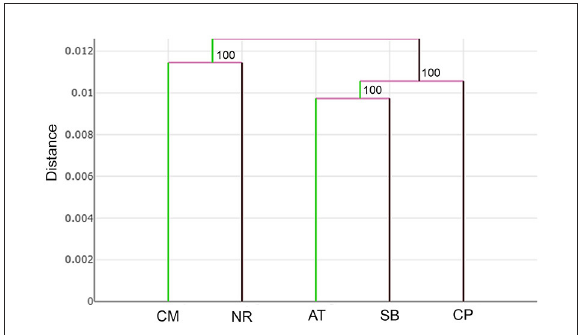
FIGURE7 UPGMA tree of Tabanus rubidus wing shape among populations (CM, Chiang Mai; NR, Nakhon Ratchasima; AT, Uthai Thani; SB, Singburi; CP, Chumphon) based on the Euclidean distances with 1,000 bootstrap replicates.